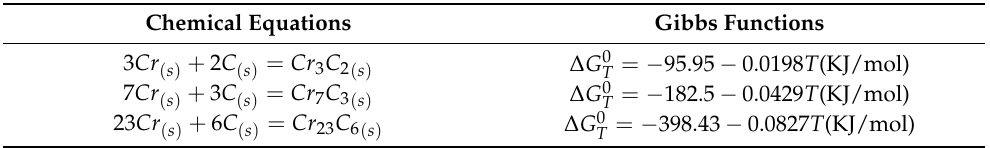
Table 2. Gibbs energies of formation of chromium